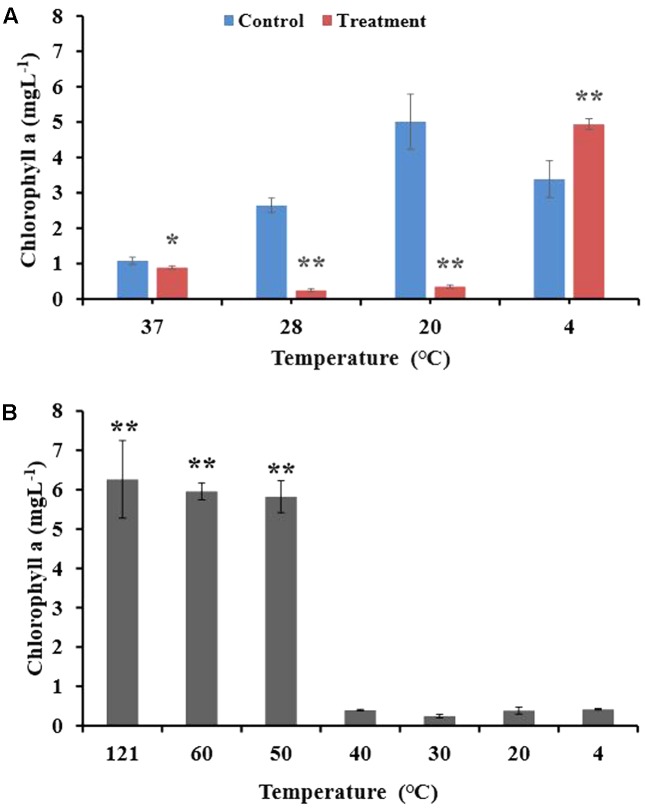
Algicidal stability of the BIAL at different culturing temperatures and its temperature sensitivity during storage. (A) Effect of culturing temperature on the algicidal activity of the BIAL. (B) Temperature sensitivity of the BIAL, Chl a under 20°C served as control. ∗p < 0.05 and ∗∗p < 0.01 represent significant differences compared to the control cells.